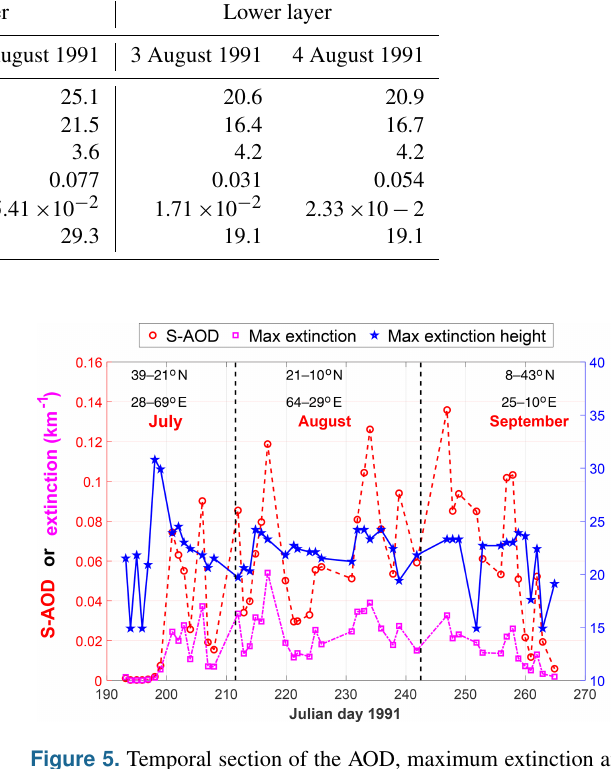
Figure 5. Temporal section of the AOD, maximum extinction and its altitude from the individual lidar profiles measured by Zubov along its